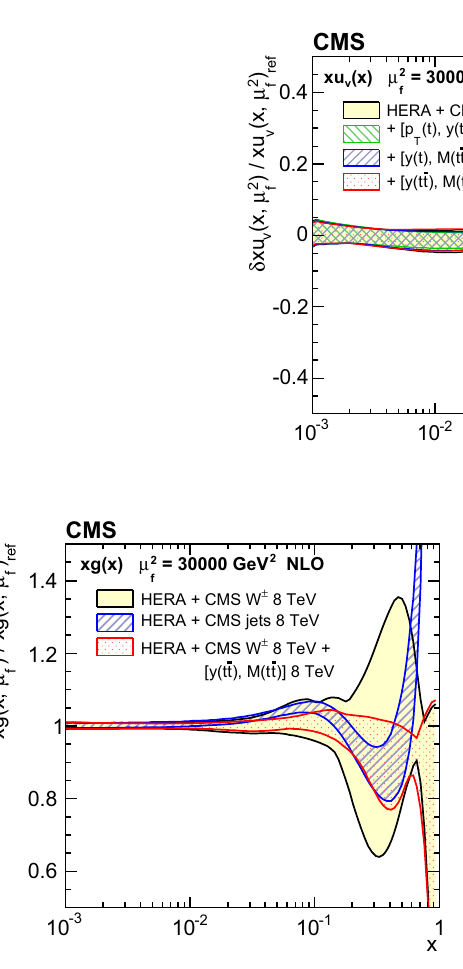
Fig. 15 Relative total uncertainties of the gluon ( upper left ), sea quark ( upper right ), u valence quark ( lower left ), and d valence quark ( lower right ) distributions at μ 2 = 30 , 000GeV 2 , shown by f shaded , hatched , and dotted areas , as obtained in all variants of the PDF fit